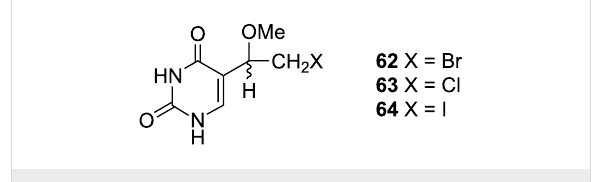
Figure 6: 5-(Methoxy-2-haloethyl)uracils 62 – 64